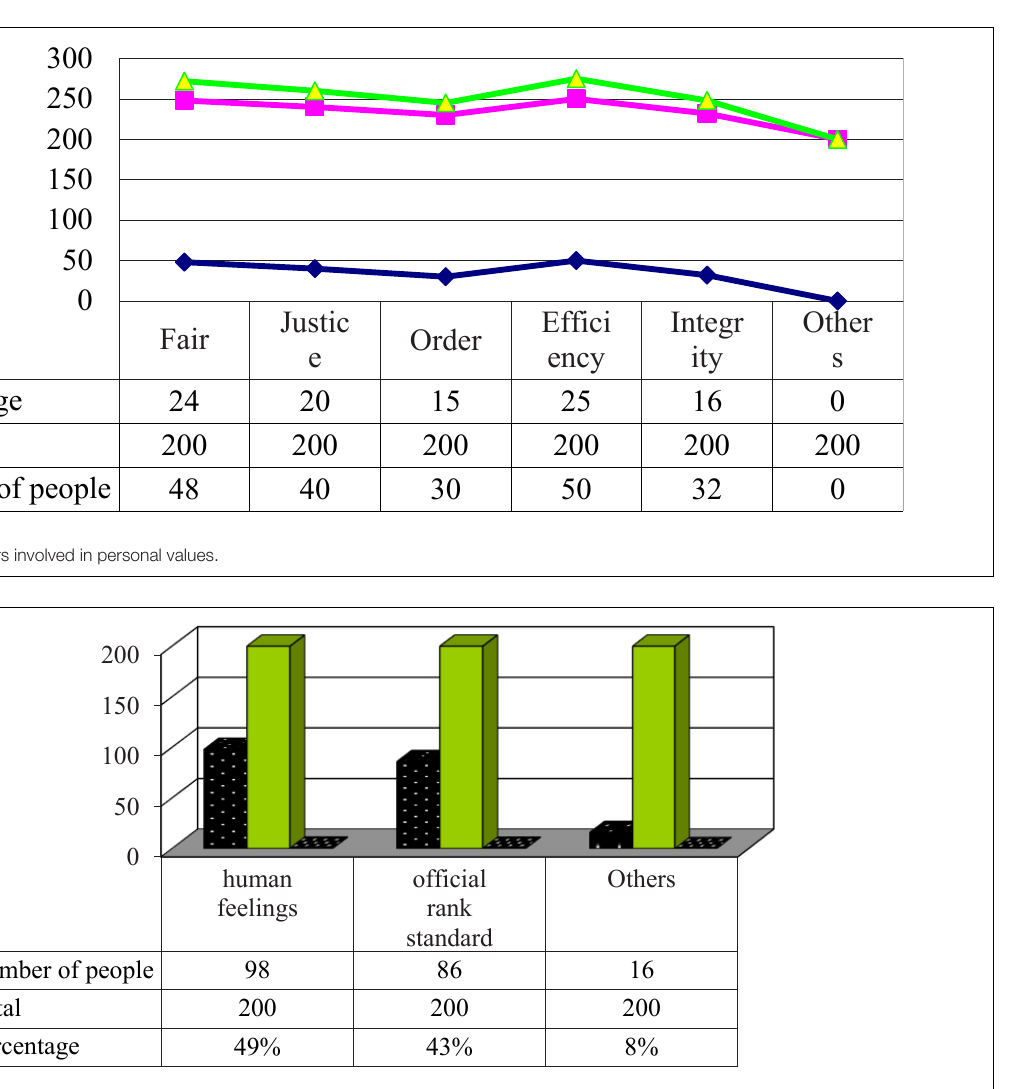
FIGURE 2 | Cultural causes of administrative